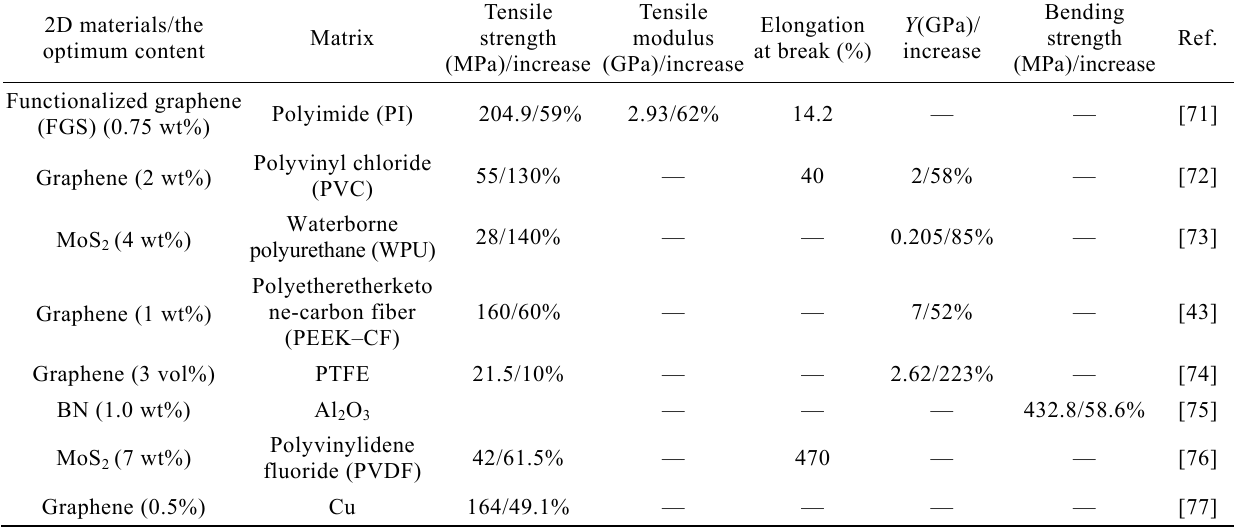
Table 3 Summary of mechanical properties of 2DNBCs. 2D materials/the Functionalized